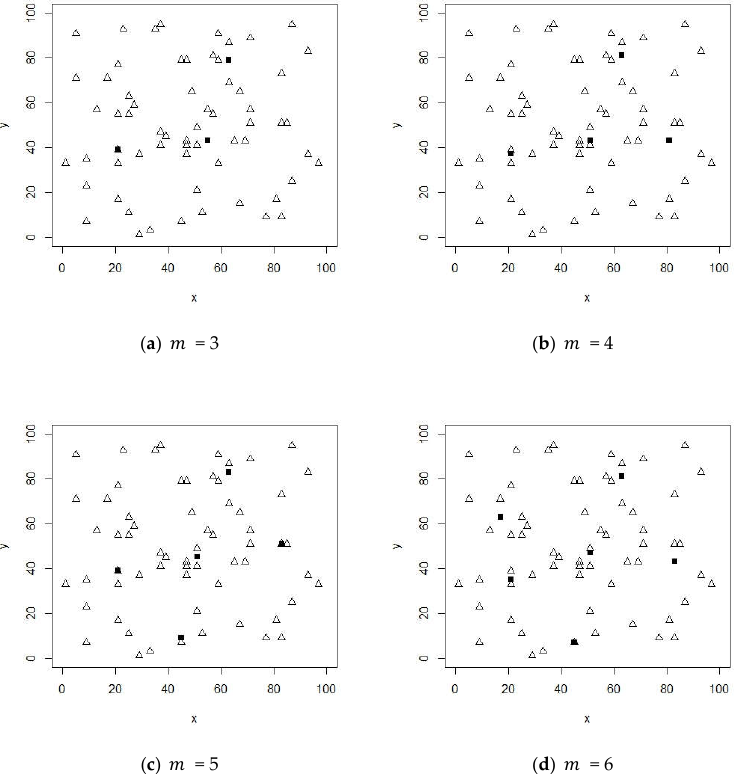
Figure 7. Globally optimal facility locations in the planning area considering capacities for Instance 24. ( a ) m = 3; ( b ) m = 4; ( c ) m = 5; ( d ) m =